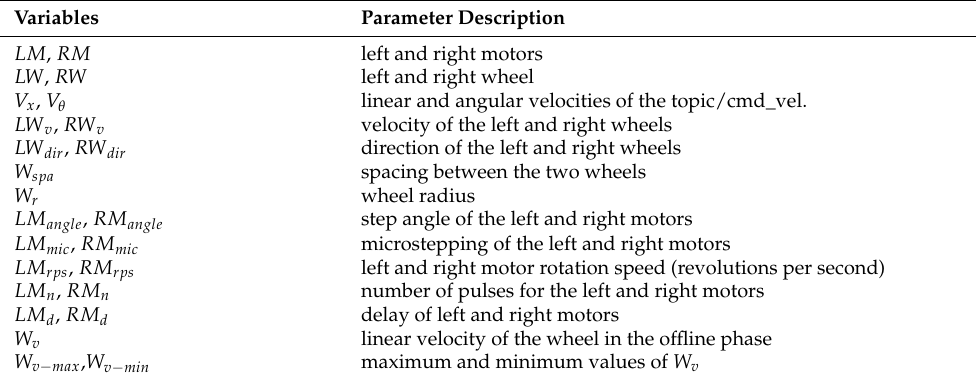
Table 4. Parameter variables of the stepping motor control